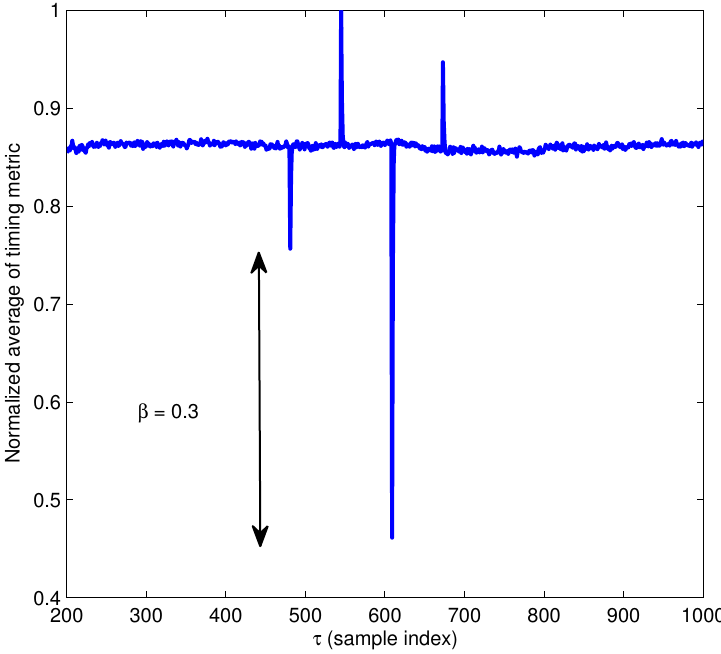
Figure 2. Plot of normalized average of the proposed timing metric (4) for a PA ACO-OFDM with N = 256, U = 5, cp = N /8, signal-to-noise ratio (SNR) = 10 dB, and 4-quadrature amplitude modulation